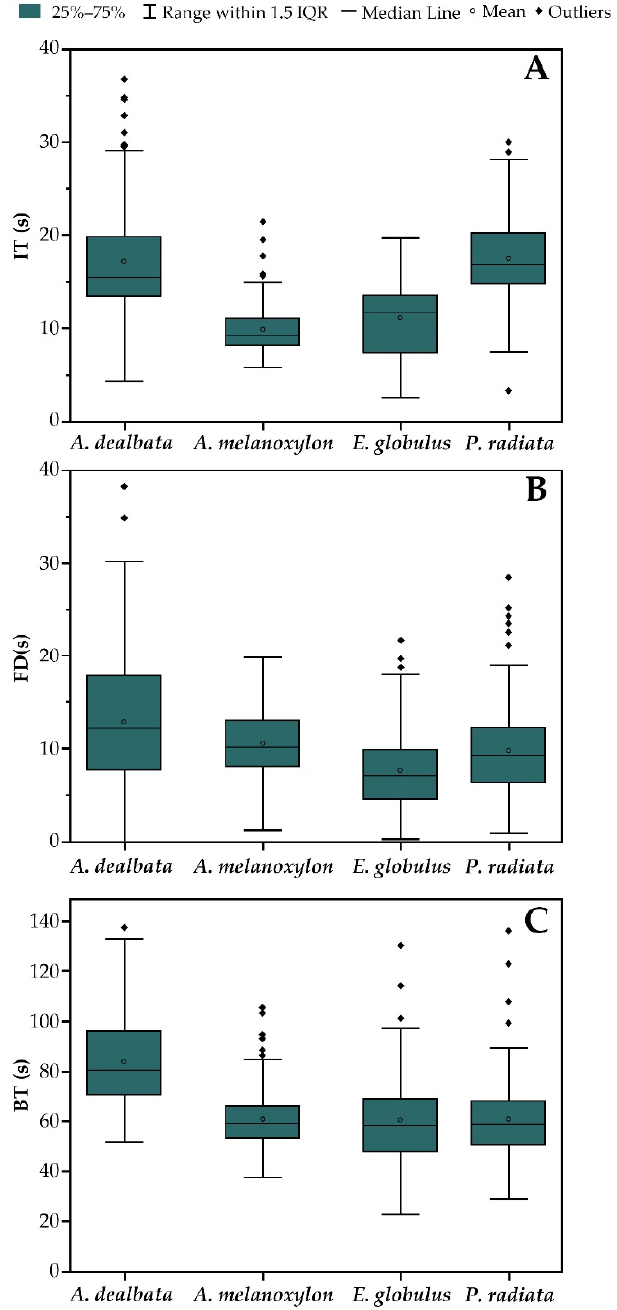
Figure 2. Box-whisker plots for the flammability parameters of exotic species analyzed during summer 2020–2021: ( A ) ignition time (IT); ( B ) flame duration (FD); and ( C ) burning time (BT). Each box is defined by the lower and upper quartiles, while the caps at the end of the box represent the range within 2.7 standard deviations considering 1.5 scale factor in IQR Method for outlier detection. The continuous horizontal line in the box is the median, open circle corresponds to the mean of the data samples, and the diamond points represent outlier samples in the data group.–